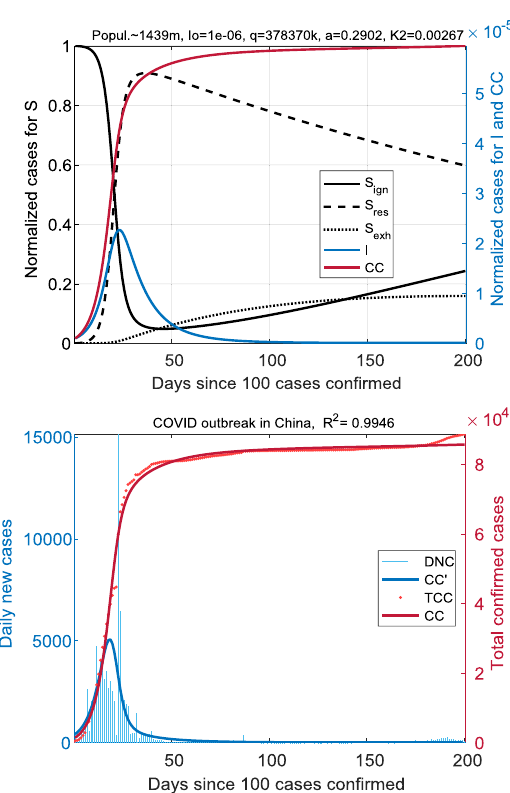
Figure 1. Coronavirus outbreak in China. The dynamics of the SIR SS model is shown in the top panel: S ign , S res , S exh , I, and CC = I + R. Fitted COVID data in absolute values (total confirmed and daily new cases: TCC and DNC) are displayed at the bottom. The beginning of the infection spread is characterized by a single wave, followed by a plateau on CC(t). Fractions S ign and S res quickly interchange with an increase in I(t), and S exh gradually increases to a relatively low level of ~